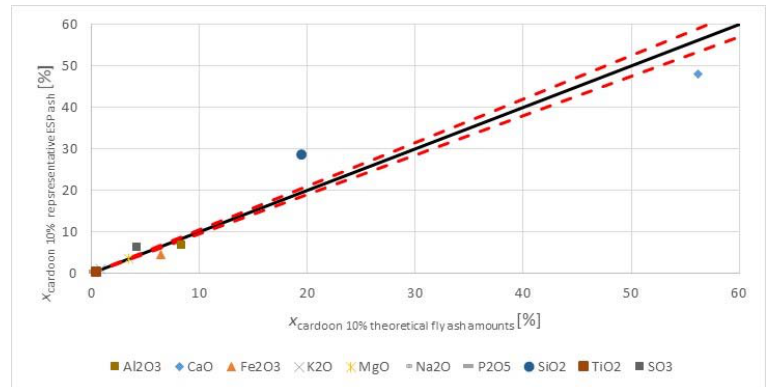
Figure 9. Enrichment of elements in the fly ash for lignite combustion; fuel ash plotted on the abscissa and representative electrostatic precipitator (ESP) ash plotted on the ordinate; dashed lines estimate the uncertainty due to analyses variability (±5%).